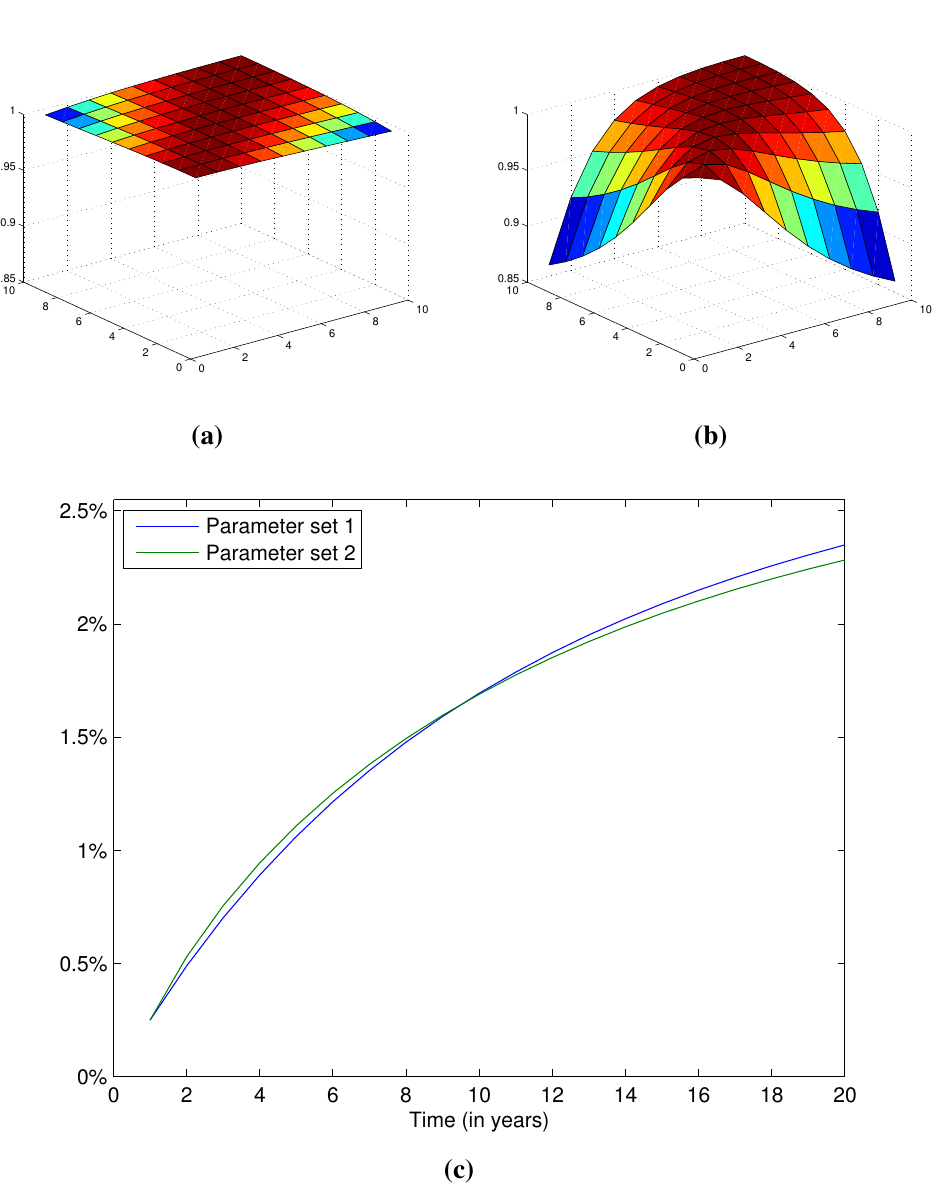
Figure 1. Correlations and yield curves for Parameter sets 1 and 2. ( a ) Correlation between bond prices for Parameter set 1; ( b ) Correlation between bond prices Parameter set 2; ( c ) Yield curves obtained using no-arbitrage bond